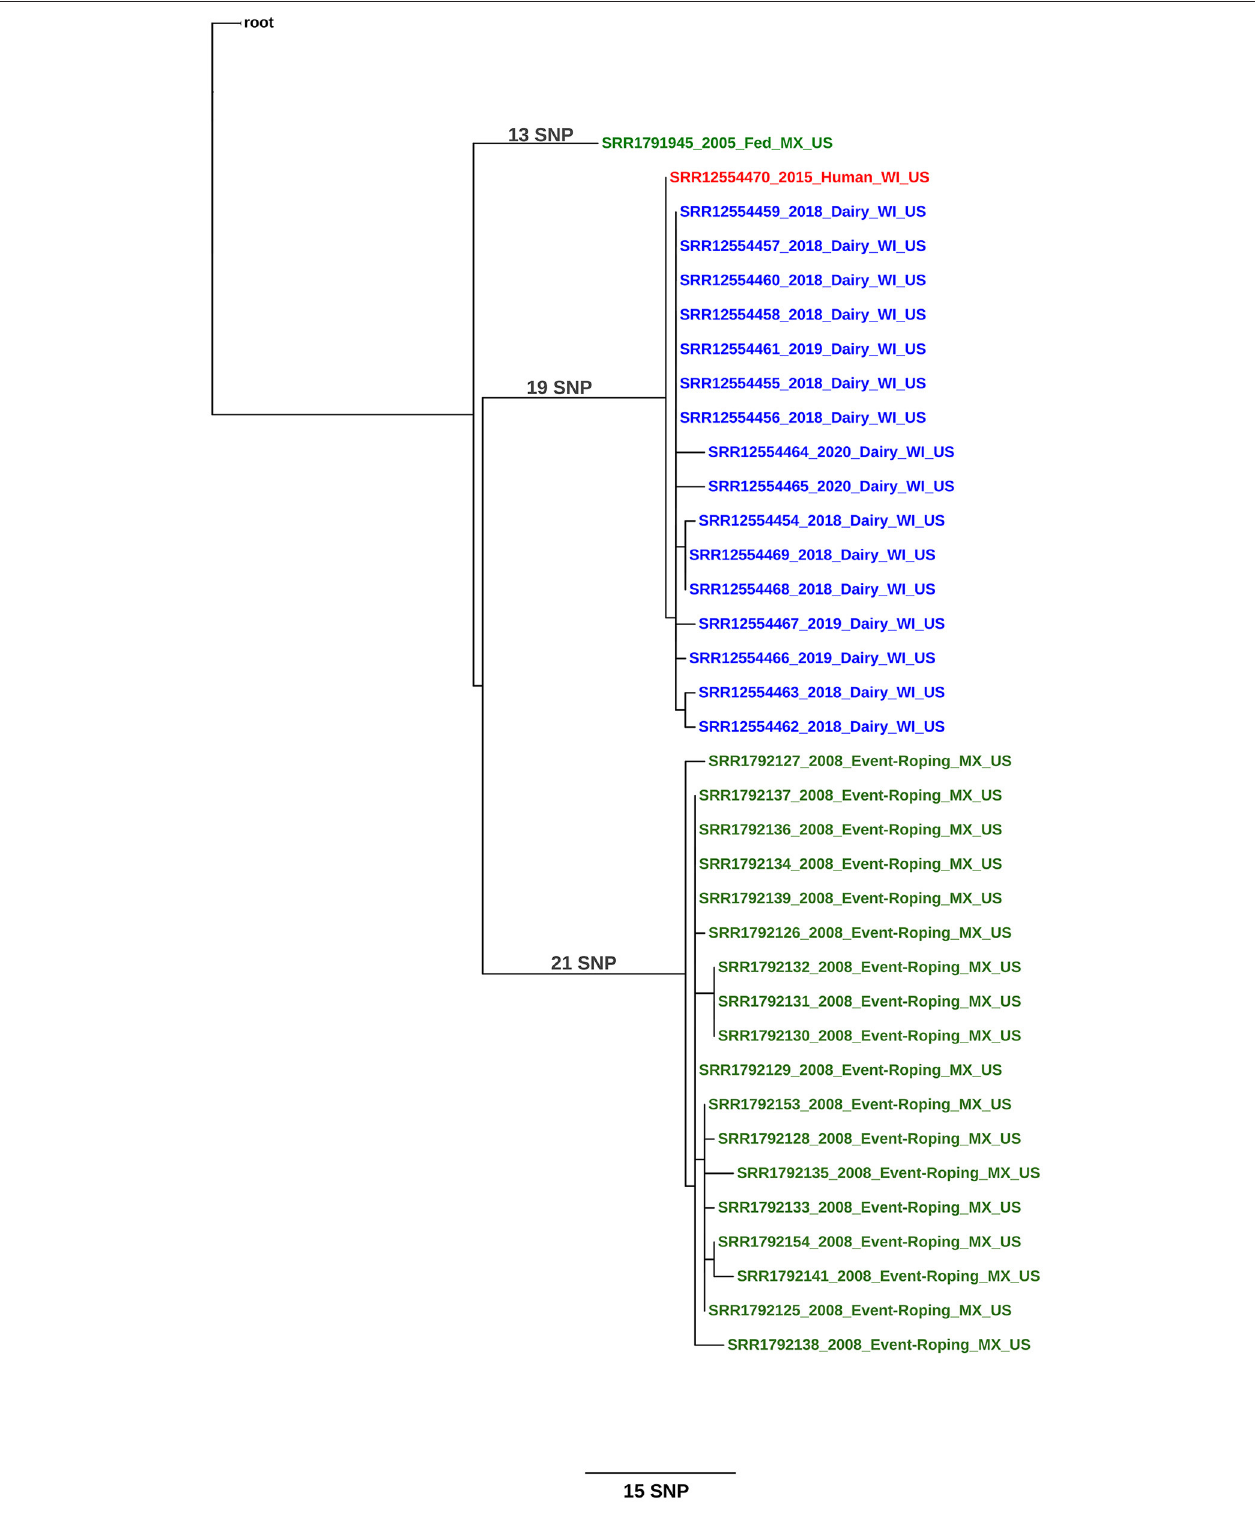
FIGURE 2 | Maximum likelihood phylogenetic tree illustrating the genetic relationship between M. bovis isolates a herd in Wisconsin (United States) and a human. The color key indicates the origin of the cattle from which M. bovis was isolated: green, Mexico and blue, United States. The human isolate is shown in red. Sequences are identified using the following syntax: NCBI SRA accession number_year of isolation_ production type (dairy, fed, event-roping)_geographical origin of the animal (state, country)_country of detection. The scale bar represents a branch length of 15 SNPs. The tree is rooted to the reference genome M. bovis AF2122/97.